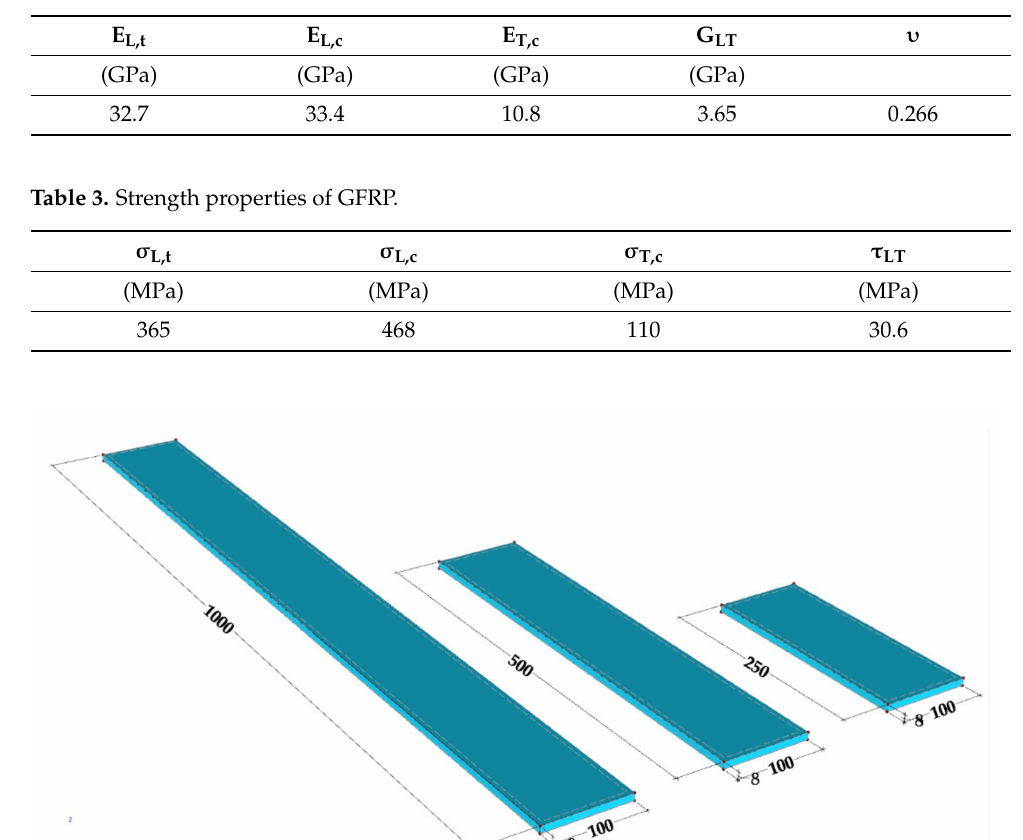
Table 2. Elastic properties of GFRP.